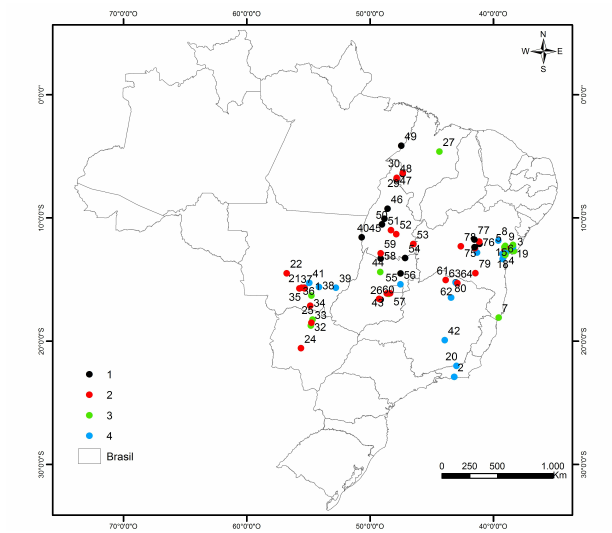
Figure 4. Geographic distribution of collection sites of the 80 Stylosanthes scabra Vogel accessions in Brazil, coloured according to the clusters in which they were